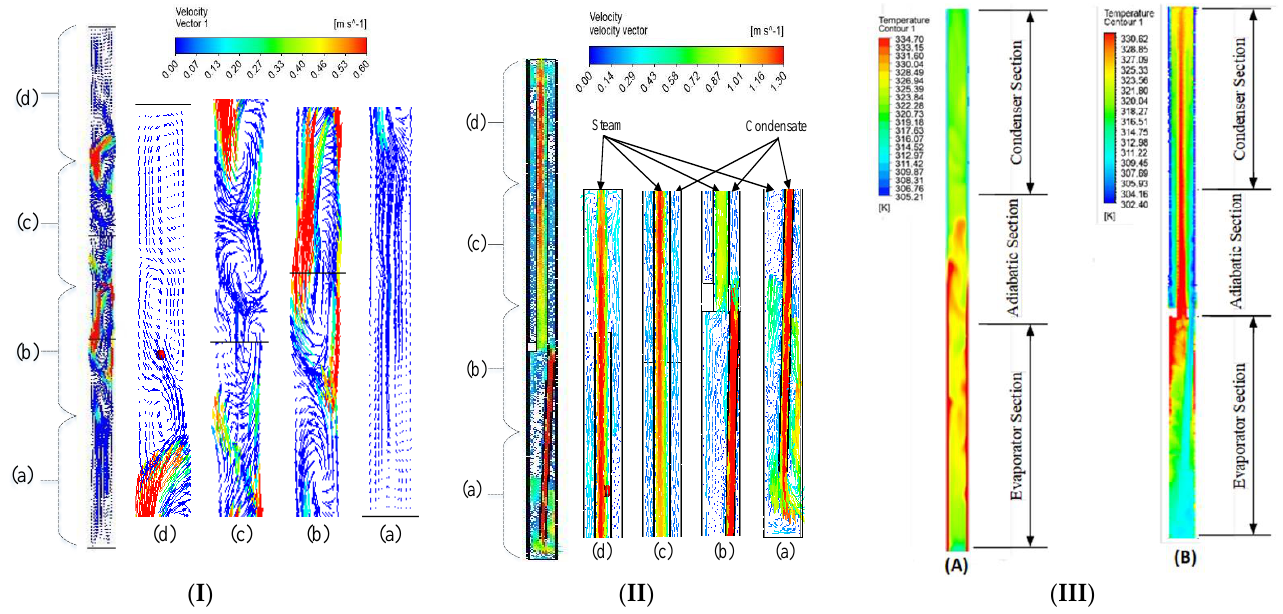
Figure 5. ( I ) Velocity vectors at longitudinal section of the vertical THP for operating conditions of (FR 50%, 100 W); ( II ) velocity vectors at longitudinal section of the vertical THP for operating conditions of (FR 55%, 100 W); ( III ) temperature distribution contours at the longitudinal section of the (A) THP ((FR 50% and 200 W) and (B) TPTHP (FR 50% and 200W).